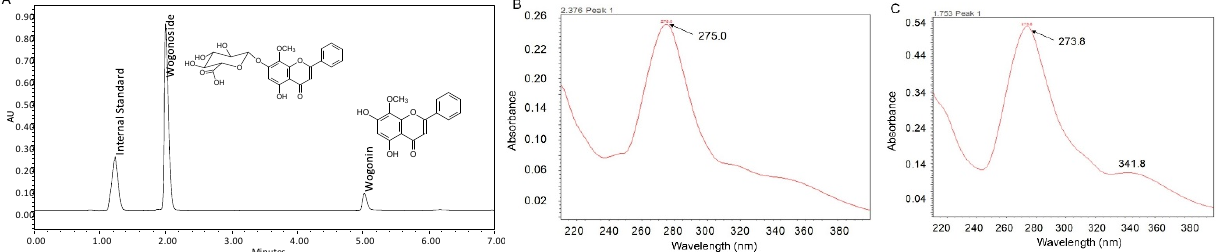
Figure 1. Chemical structures, UV, and a representative UPLC chromatogram of wogonoside and wogonin. Analysis was performed using a Waters Acquity UPLC with photodiode array detector ( A ) a representative chromatogram of wogonoside, wogonin, and I.S.; ( B ) UV spectrum of wogonoside; ( C ) UV spectrum of wogonin.